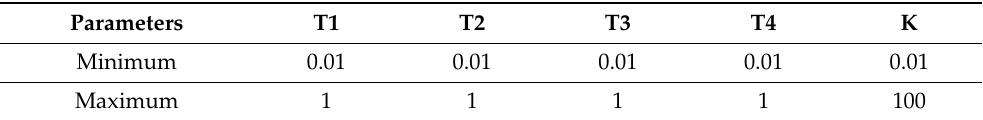
Table 1. Typical range of single-input PSS optimized parameters.